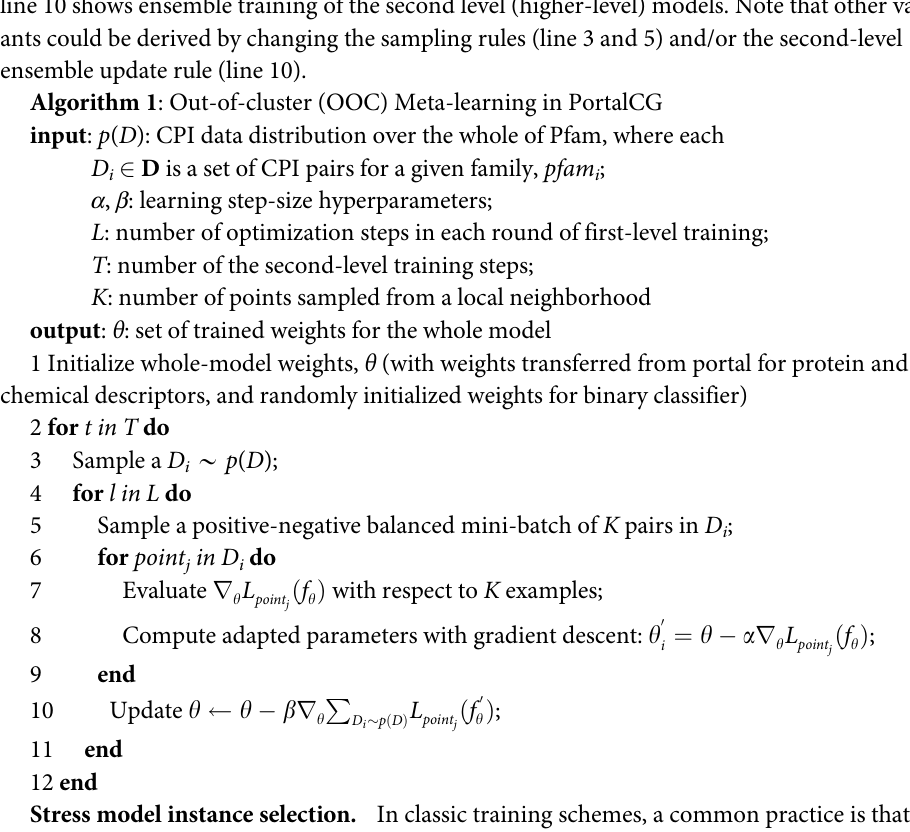
Algorithm 1 : Out-of-cluster (OOC) Meta-learning in